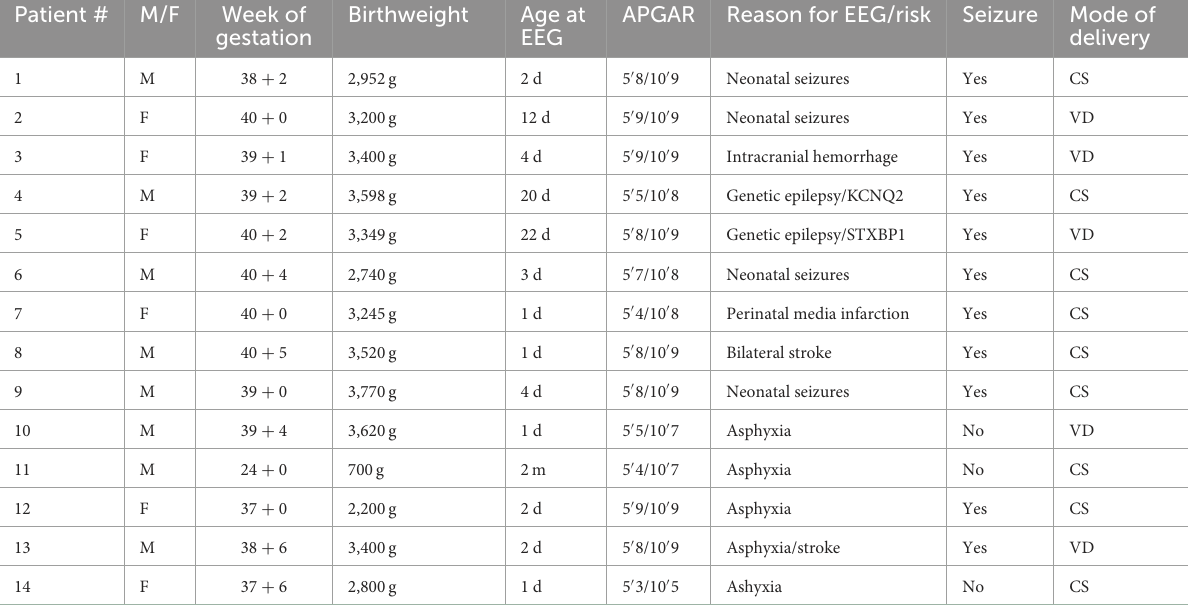
TABLE 1 Clinical details of all analyzed patients.